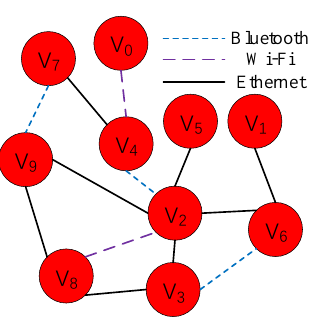
Figure 2. An edge network.